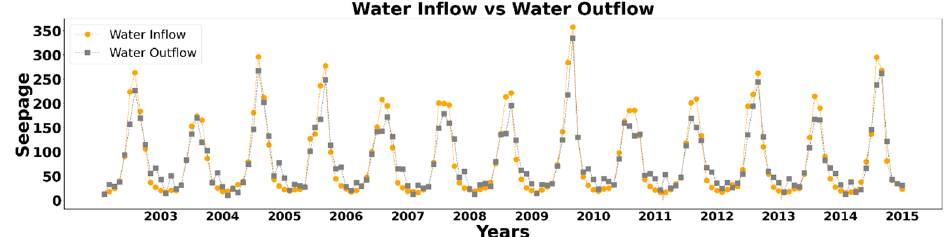
Figure 9. Comparison of Water Inflow and Outflow in Tarbela Dam.